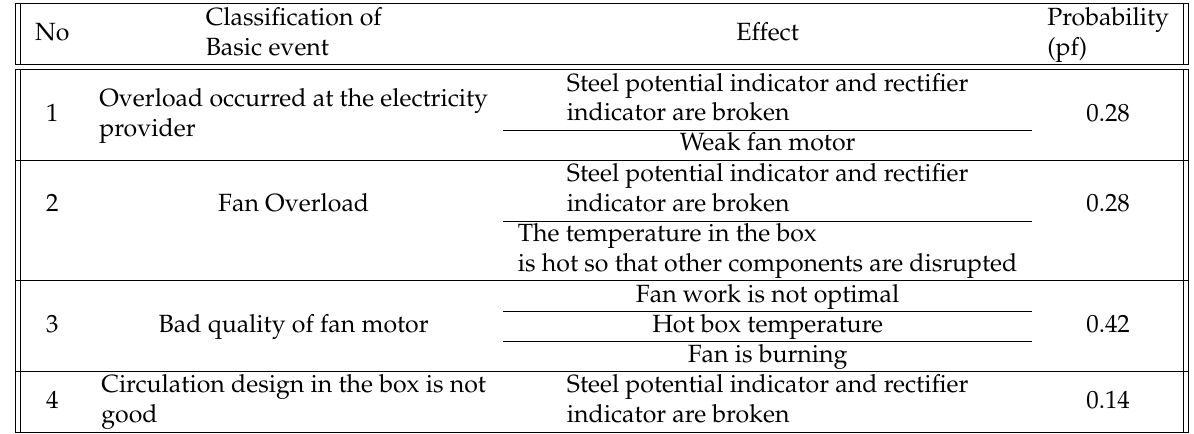
Table 6. Result of Risk Priority Number (RPN) scores for Failure in